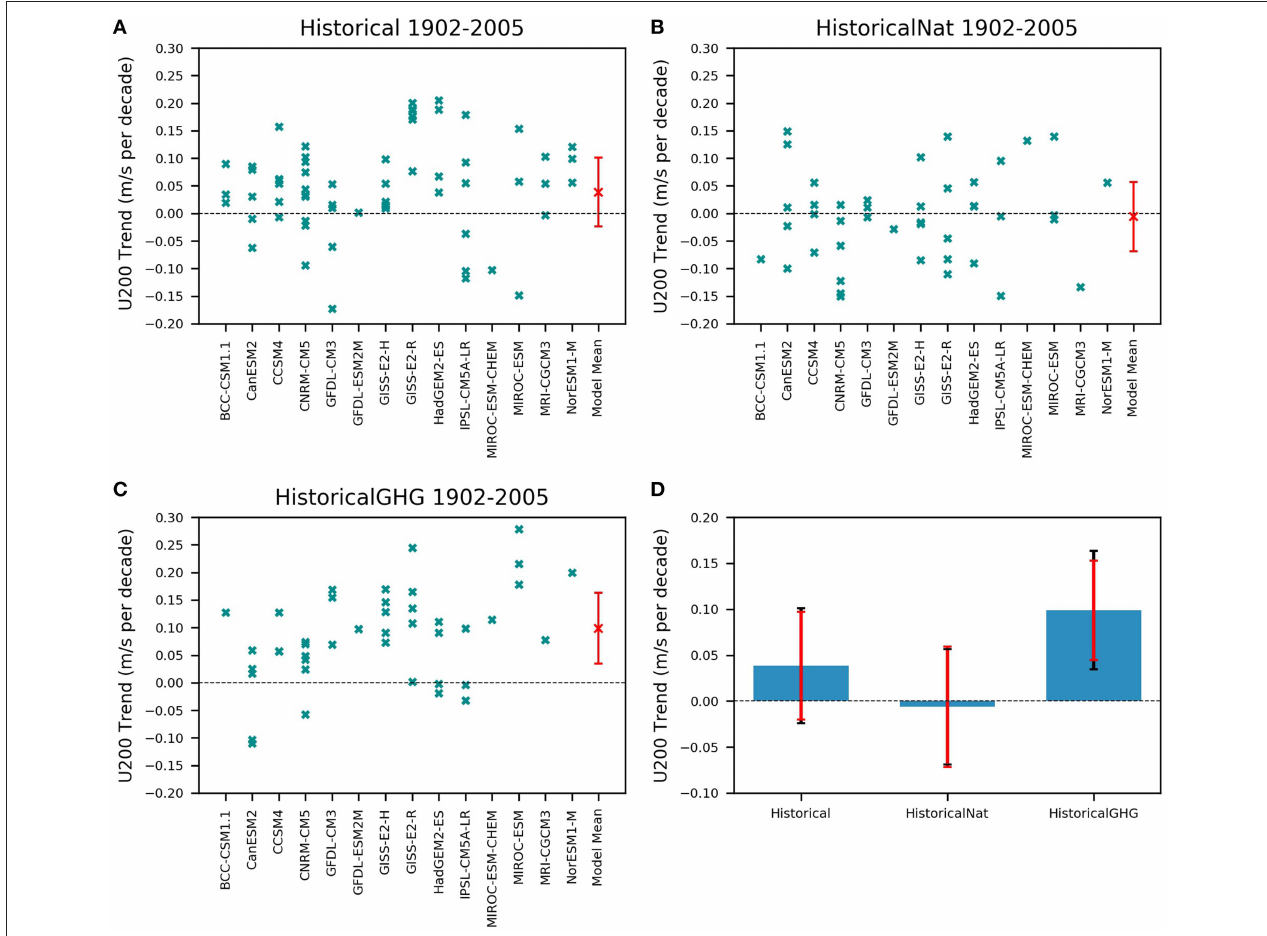
FIGURE 2 | Central Andes region U200 trends (units in m/s/decade − 1) for all CMIP5 model simulations considered (cyan crosses) and multi-model mean (red cross), for (A) Historical simulations, (B) HistoricalNat simulations and (C) HistoricalGHG simulations. Red bar in multi-model mean indicates the dispersion between models. (D) Simulations multi-model means U200 trends (blue bars), inter-model dispersion (black bars), and the uncertainty due to internal climate variability (red bars), computed as described in section Data and Methods.